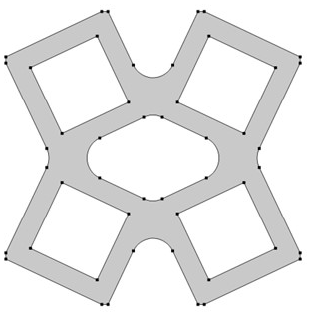
Figure 10. The obtained unit cell for fillet radius = 0.15.